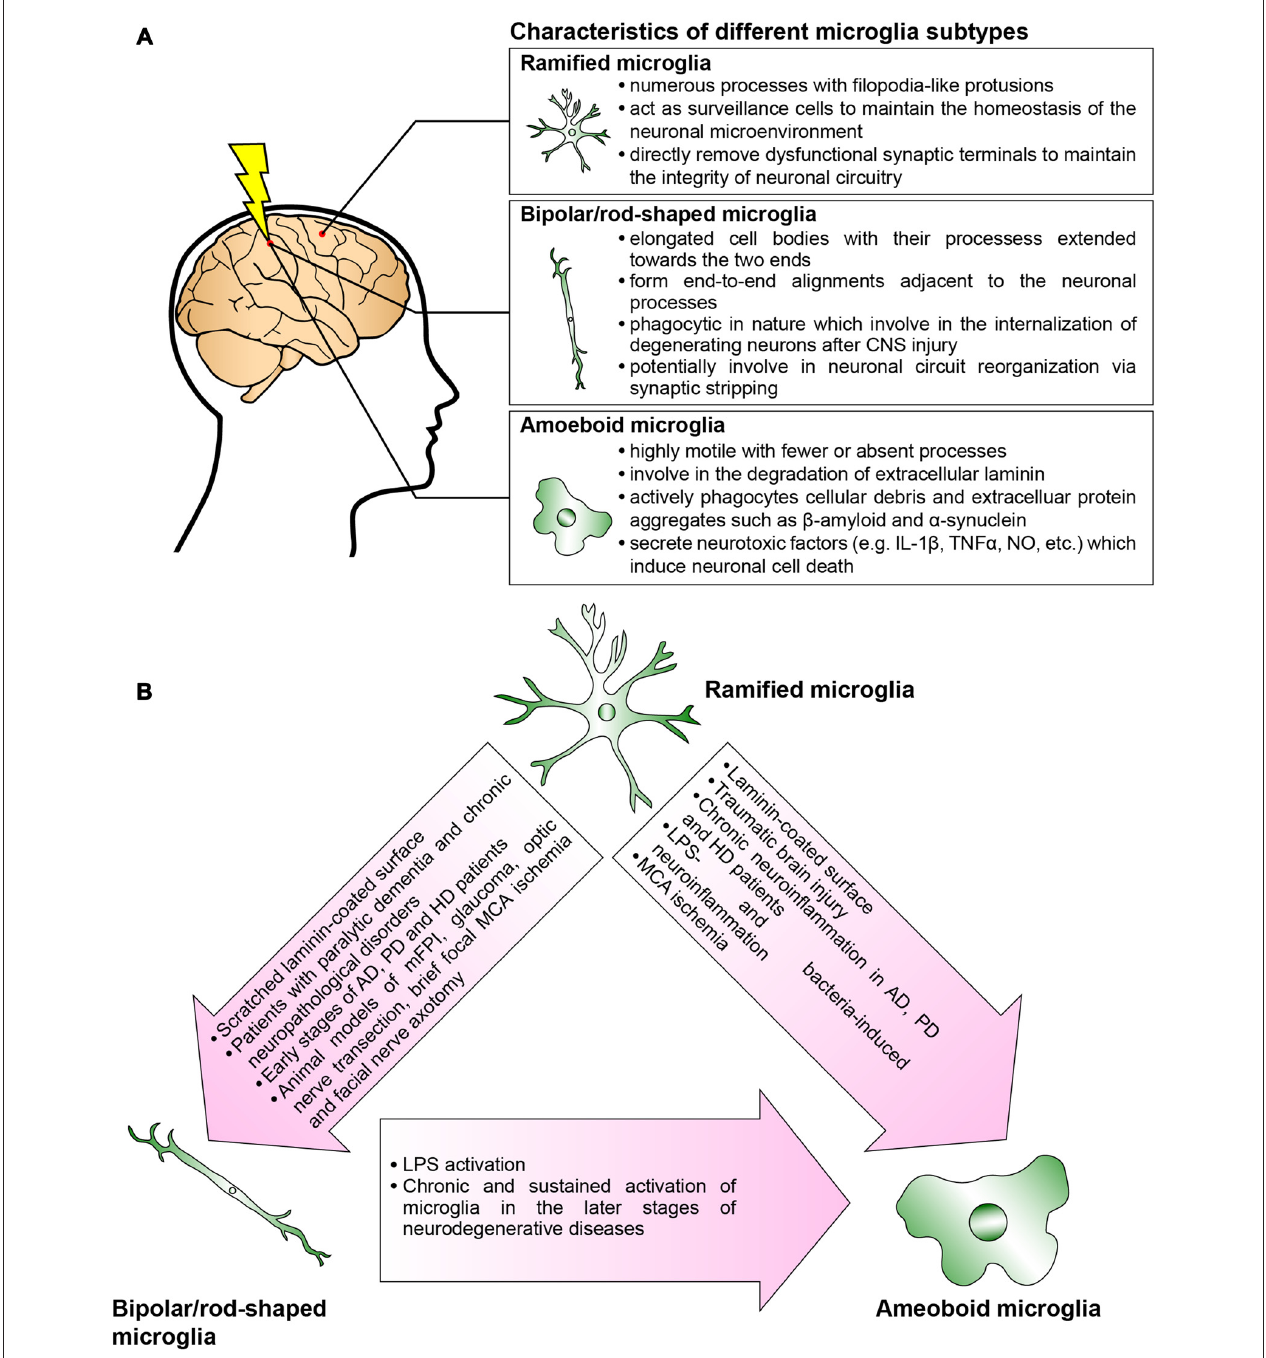
FIGURE 2 | Microglia are phenotypically dynamic. (A) The functional roles of microglia in normal or pathological central nervous system (CNS) are tightly associated with their morphological changes. Ramified microglia actively sense the subtle changes in CNS microenvironment. Bipolar/rod-shaped microglia form end-to-end alignments in close proximity to damaged neuronal fibers, suggesting that their functions are related to synaptic reorganization. Amoeboid microglia are extremely motile which actively migrate towards the injury site. They are highly phagocytic to internalize cellular debris and secrete neurotoxic factors which induce neuronal cell death. However, there are microglia subtypes that have yet not been fully characterized (i.e., hyper-ramified, bushy-like and spider-like microglia; Karperien et al., 2013; Ziebell et al., 2015). (B) In normal healthy CNS, most of the microglia are displayed as ramified microglia. In response to the change in the microenvironment, the ramified microglia undergo rapid transformation into bipolar/rod-shaped microglia or amoeboid microglia depending on the types of stimulus. Bipolar/rod-shaped microglia can quickly transform into amoeboid microglia in response to lipopolysaccharide (LPS) activation. The amoeboid microglia transformed from bipolar/rod-shaped microglia secrete pro-inflammatory cytokines and degrade extracellular laminin.